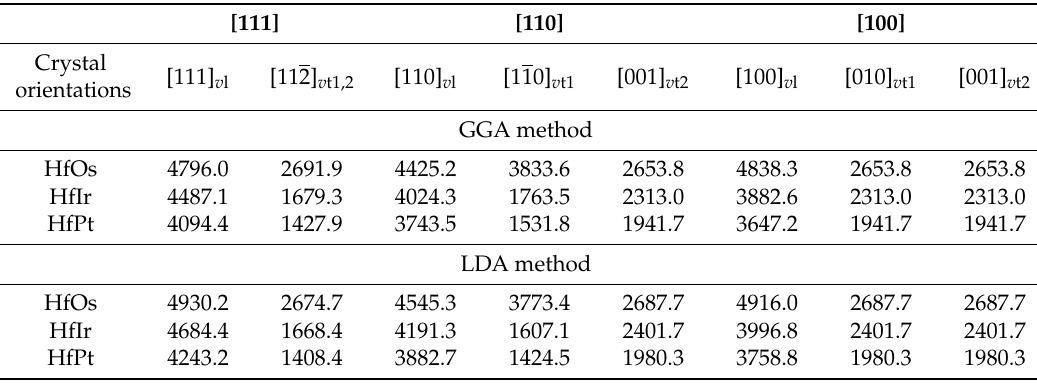
Table 5. The calculated anisotropic sound velocities (m/s) for HfX (X = Os, Ir and Pt).